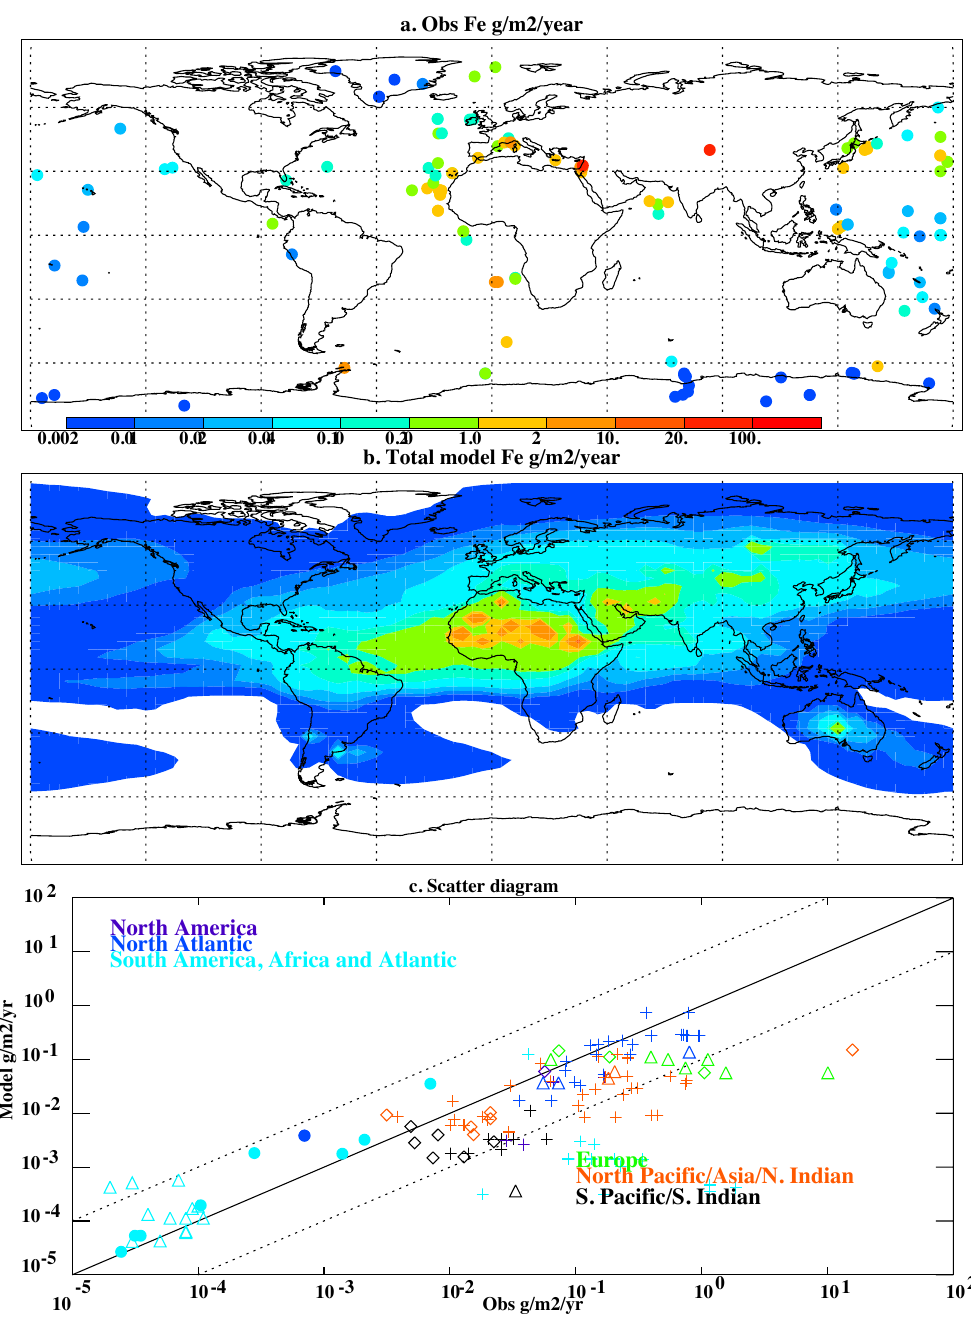
Fig. A2. Iron deposition rates from available measures (a) compared to model estimates (based on 3.5% iron in desert dust) (b) , and shown in scatterplot format (c) . The data compilation comes from (Mahowald et al.,